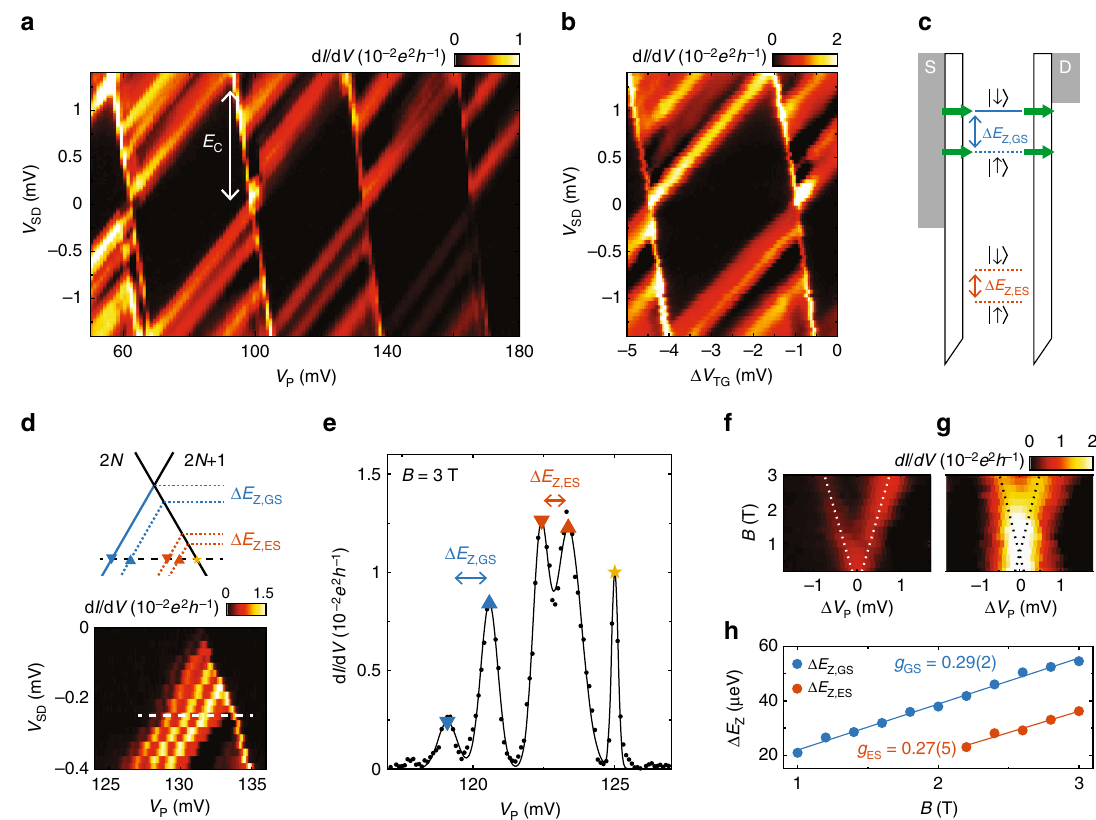
Fig. 3 Bias spectroscopy and g -factor measurements. a , b Colour plots of bias spectroscopy as a function of V P ( a ) and Δ V TG = V TG + 2084 mV ( b ), showing Coulomb diamonds with E C = 1.3(1) meV. c Schematic drawing of the Zeeman splitting Δ E Z = g μ B B of the quantum dot levels, illustrating the hole transport via the Zeeman-split energy levels. d Bias spectroscopy showing the line splitting in a 2.9 T in-plane fi eld. Dashed line indicates the cut plotted in e . e Differential conductance as a function of Δ V P for B = 3 T, at V SD = − 0.26 mV. Solid line corresponds to a fi t to the data using the sum of fi ve Gaussian pro fi les. f , g Differential conductance for both the ground ( f ) and the excited state ( g ) as a function of B and Δ V P , with Δ V V being the average voltage of the two transition peaks corresponding to either the ground or the excited state (for raw data, see Supplementary Fig. 3). peak Dotted lines represent linear fi ts to the peak positions (same as in g ). h Energy splittings for the ground and excited state as a function of B . Solid lines are linear fi ts to the data yielding the corresponding g